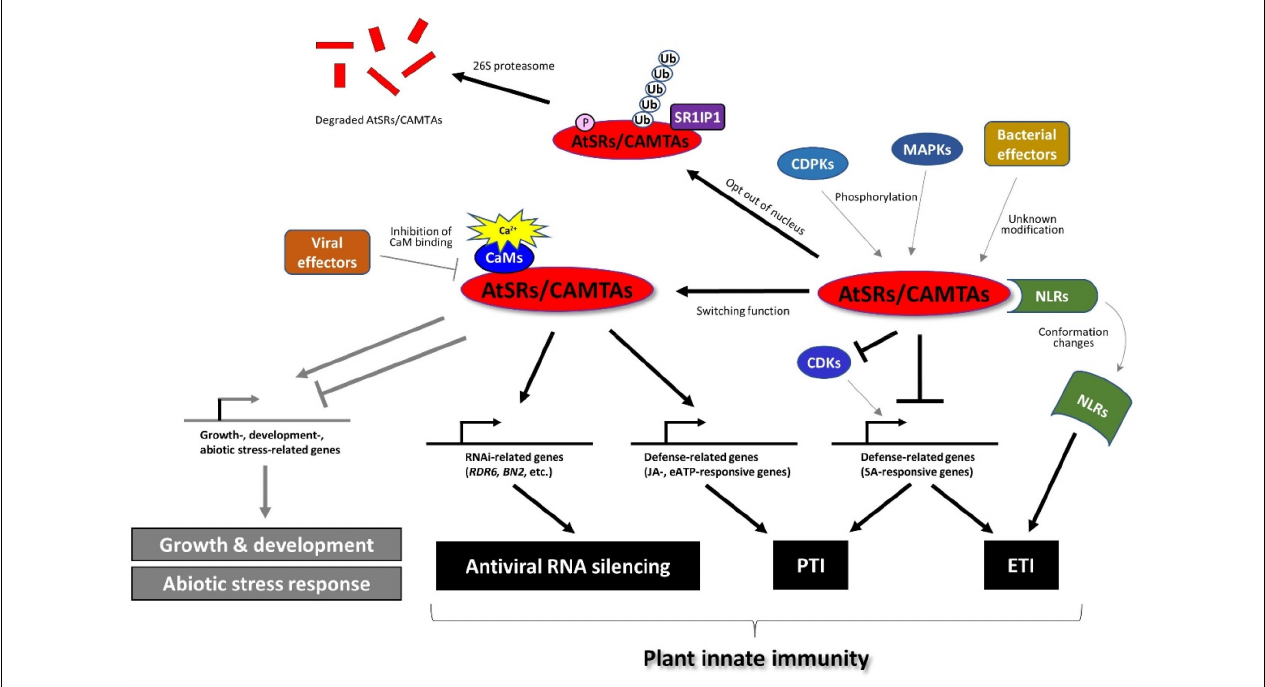
FIGURE 3 | AtSRs/CAMTAs play the role of a hub in plant immune response. AtSRs are the suppressor of plant immunity and repress defense-related gene expressions through the interaction with the “CGCG” box in their promoter. Pathogen infection induces Ca 2 + influx as described in Figure 1 , which impacts the Ca 2 + -CaM-AtSRs complex and subsequently removes the suppressor of AtSRs in SA-based plant immunity to induce the defense-related gene expression (e.g., EDS1, and NPR1, etc.). However, effector proteins derived from the bacterial pathogens (e.g., Pst carrying AvrRpt2 or AvrRps4) modify AtSRs, which is sensed by NLRs, e.g., DSC1 and DSC2, followed by inducing ETI-based plant defense response. In addition, the rise of cytoplasmic Ca 2 + activates MPKs and CPKs, which phosphorylate AtSRs, resulting in the export of AtSRs from the nucleus and eventually the degradation of AtSRs. In contrast, AtSRs act as transcriptional activators for plant immune response by reprograming the transcription of JA- and eATP-responsive genes. In addition, CaM-AtSRs interaction is targeted by viral effectors, e.g., V2 derived from the geminivirus CLCuMuV, which regulates RNAi-mediated immune response against viral infection. In other respects, AtSRs also play an important role in plant growth, development, and abiotic stress responses, which are not discussed in this